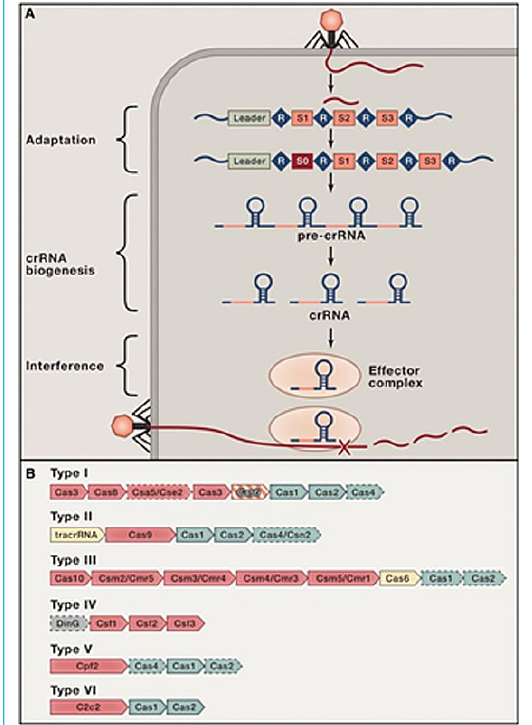
Figure 2: Function and organisation of CRISPR systems. (A) CRISPR immunity occurs in three stages. Upon introduction of for- eign DNA, the adaptation machinery selects protospacers and in- serts them into the leader end of the CRISPR locus. During crRNA biogenesis, the CRISPR locus is transcribed and sequence ele- ments in the repeats direct processing of the precrRNA into cr- RNAs each with a single spacer. The crRNA then assembles with Cas proteins to form the effector complex, which acts in the inter- ference stage to recognise foreign nucleic acid upon subsequent infection and degrade it. (B) CRISPR systems are extremely di- verse but can largely be classified into six major types. Represen- tative operons for each type are shown here. Genes only present in some subtypes are shown with dashed outlines. Genes involved in interference are coloured red, those involved in crRNA biogene- sis are coloured yellow, and those involved in adaptation are coloured blue. Type IV systems are notable for their frequent oc- currence in the absence of CRISPR loci.Reproduced with permis- sion from Wright AV, Nuñez JK, Doudna JA. Biology and applica- tions of CRISPR systems: harnessing Nature's toolbox for genome engineering. Cell. 2016;164(1–2):29–44. doi: 10.1016/ j.cell.2015.12.035